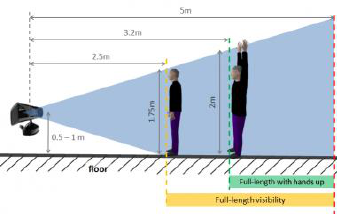
Figure 3. Recording area for Kinect 2.0 (Source: https://wiki.ipisoft.com)